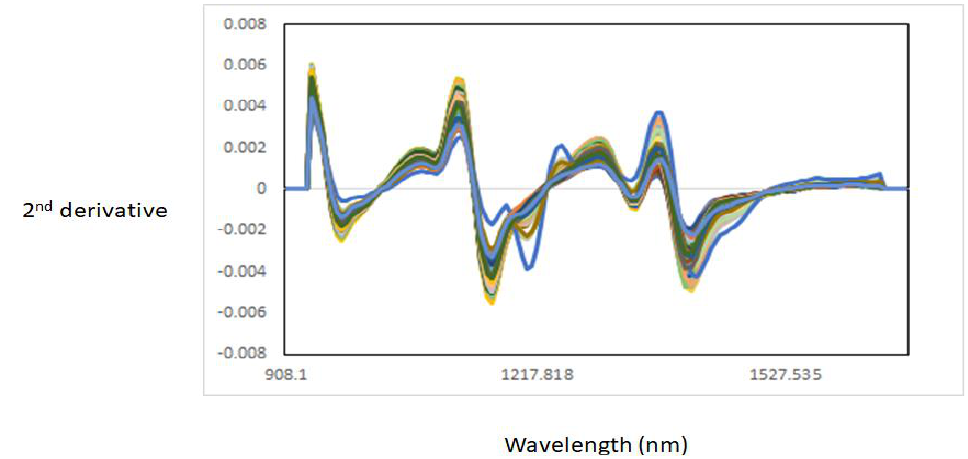
Figure 2. Near-infrared second-derivative spectra of all different intact goat muscle samples analysed.